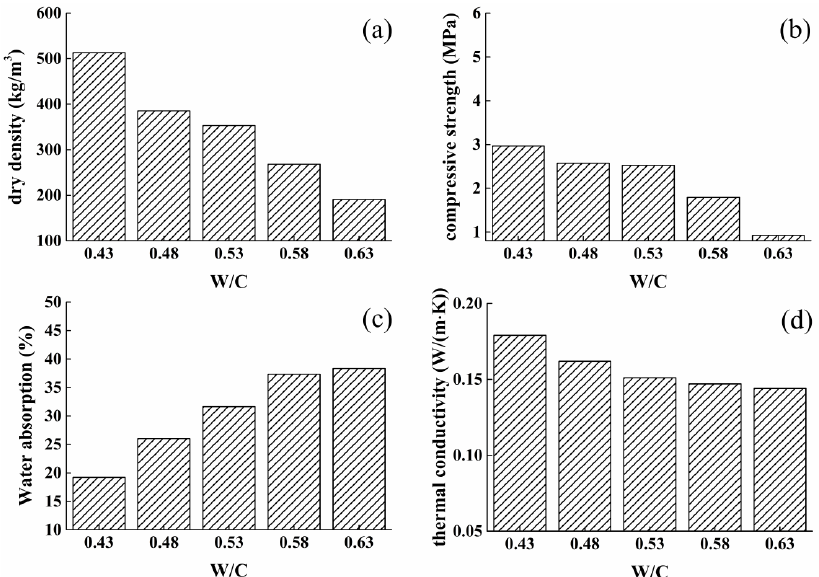
Figure 4. Effect of water-cement ratio on properties of foamed concrete: (a) dry density; (b) compressive strength; (c) water absorption; (d) thermal conductivity. strength; ( c ) water absorption; ( d ) thermal